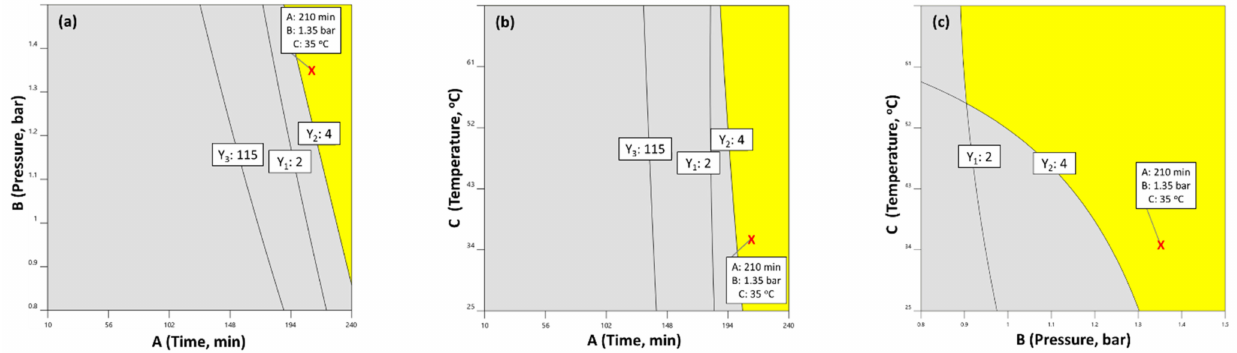
Figure 5. Overlay contour plot depicting the optimum DSp (yellow area). The red x-mark shows the selected optimum conditions: ( a ) distillation time 210 min, ( b ) pressure 1.35 bar, and ( c ) tempera- ture 35 ◦